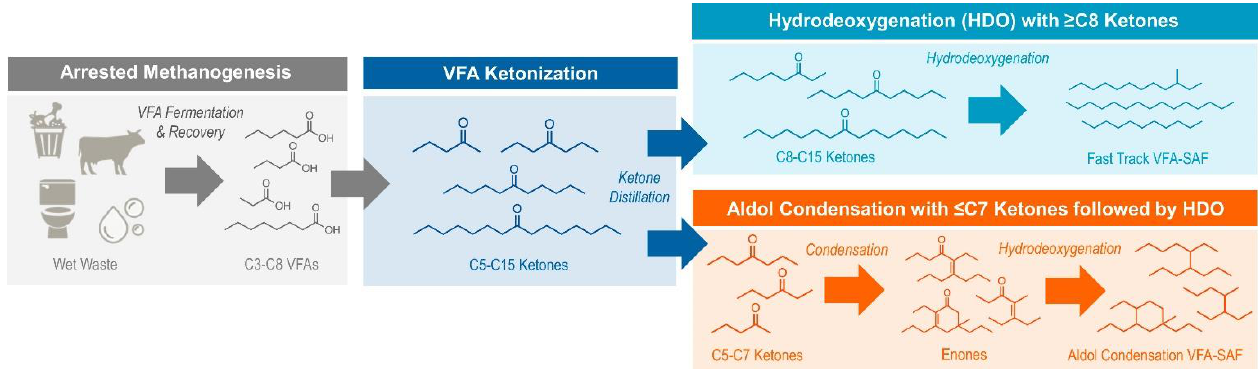
Figure 2. Overall schematic of producing SAF from VFA as platform molecule [150] (reprinted with permission).